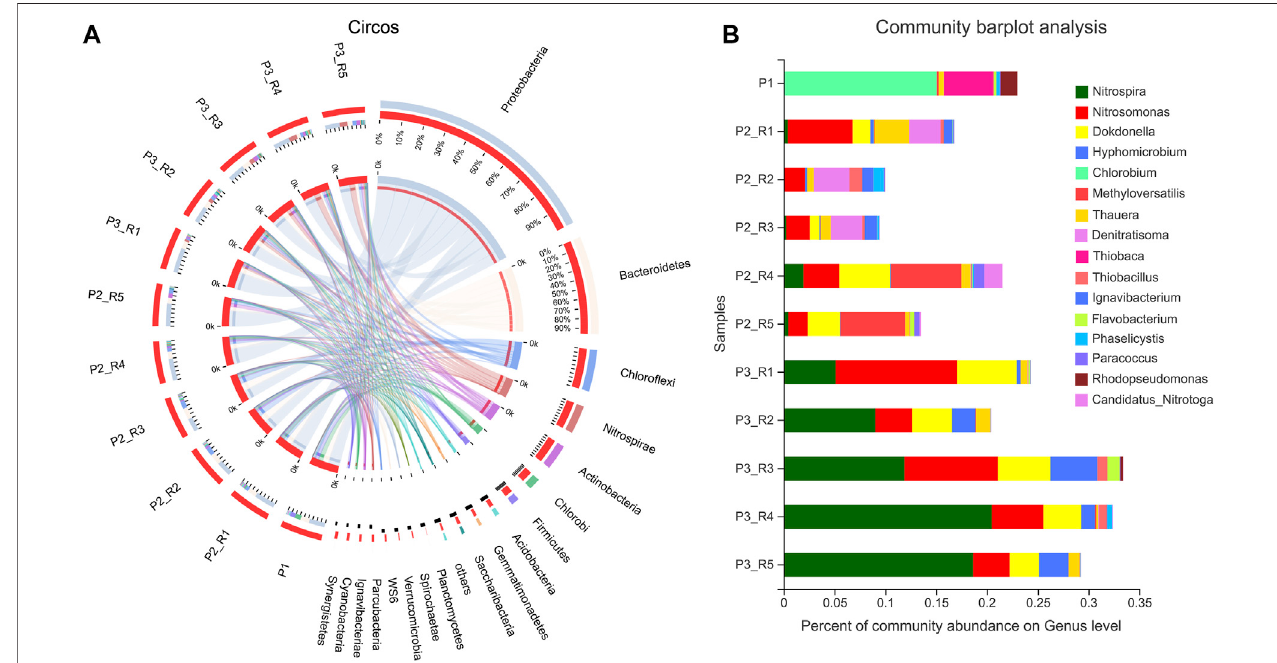
FIGURE 4 | (A) Distribution of phylum on different carriers based on the taxonomy annotations from NCBI-NR database. (B) Percent abundances of the quantitatively prominent bacteria by genus (B) in these samples.